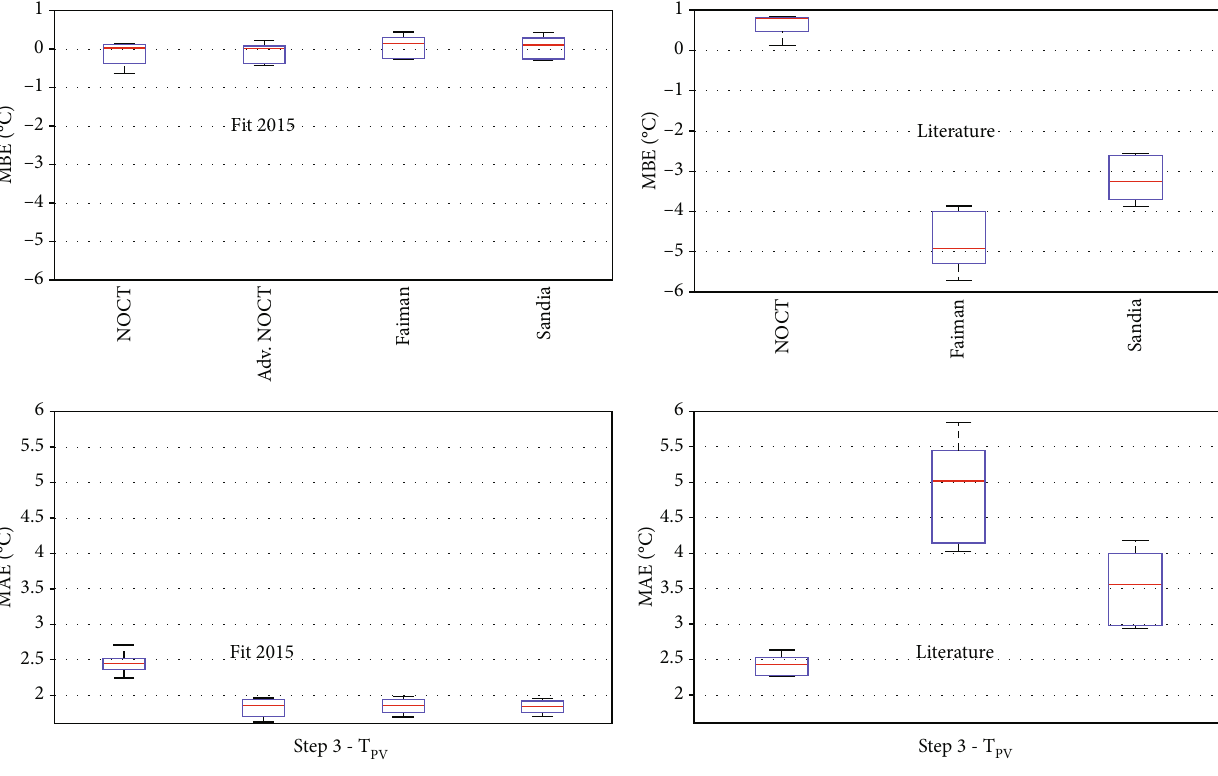
Figure 5: MBE (upper) and MAE (lower) of the presented models to calculate T literature coe ffi cients (right). Computed data are summarized in Figure 9 of Appendix B.